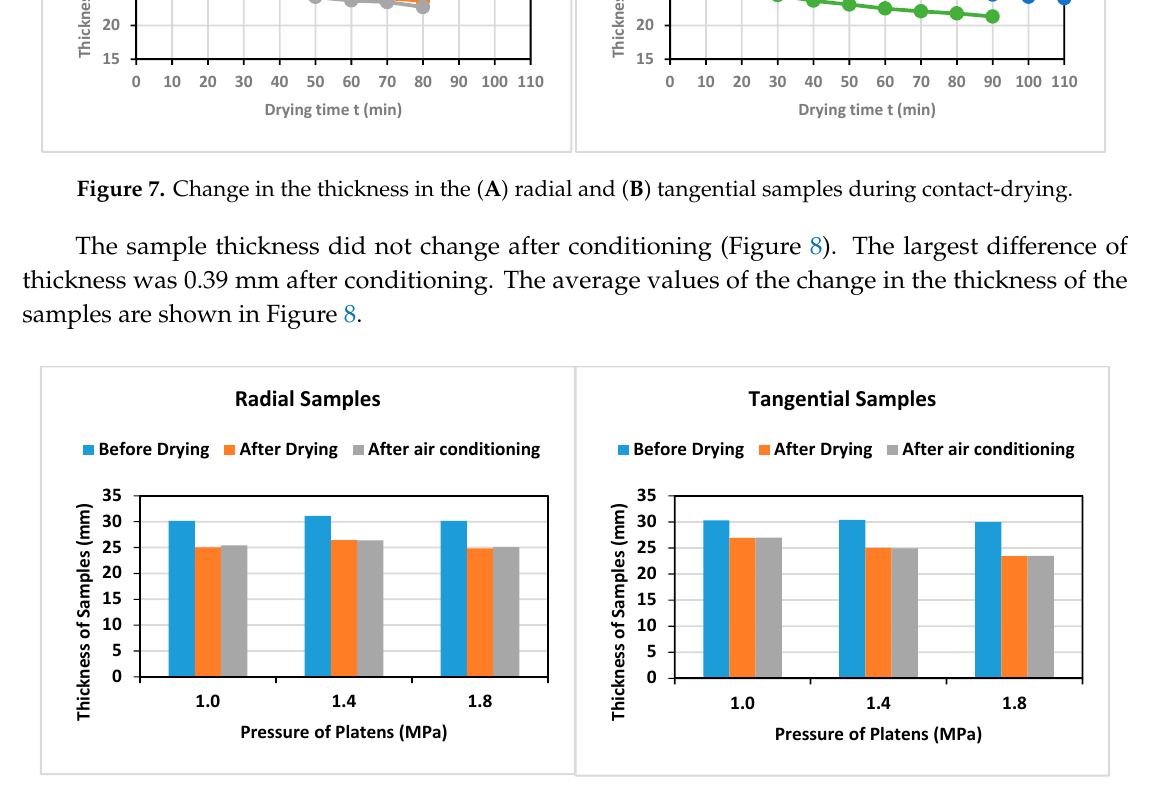
Figure 9. Development of wood hygroscopicity at time in the case of the ( A ) radial and ( B ) tangential samples.